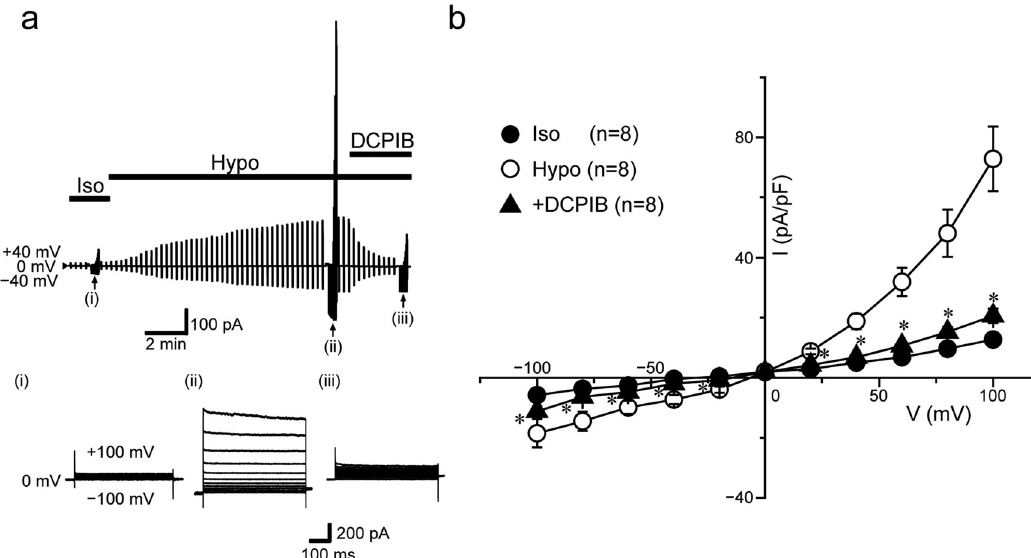
Fig. 3 Endogenous VSOR activity in DT40 cells. a Representative recording showing the time course of whole-cell currents before ( Iso ) and after ( Hypo ) hypotonic stimulation (86% osmolality) in the absence and presence of DCPIB (10 µ M). Currents were elicited by alternating pulses from 0 to ±40 mV. Step pulses from − 100 to + 100 mV in 20-mV increments were applied at time points indicated by (i), (ii), and (iii). Bars above the recordings indicate the time during applications of hypotonic solution and DCPIB (10 µ M). b Mean I – V relationships for isotonic ( Iso ) and hypotonicity-induced ( Hypo ) whole-cell currents before and during application of DCPIB ( + DCPIB : n = 8). Each data point represents the mean ± SEM (vertical bar) of n samples. * P ( = 0.048, 0.028, 0.0499, 0.0054, 0.016, 0.0018, 0.00050, 0.00056, 0.0011, and 0.00031 at − 100, − 80, − 60, − 40, − 20, + 20, + 40, + 60, + 80, and + 100 mV,